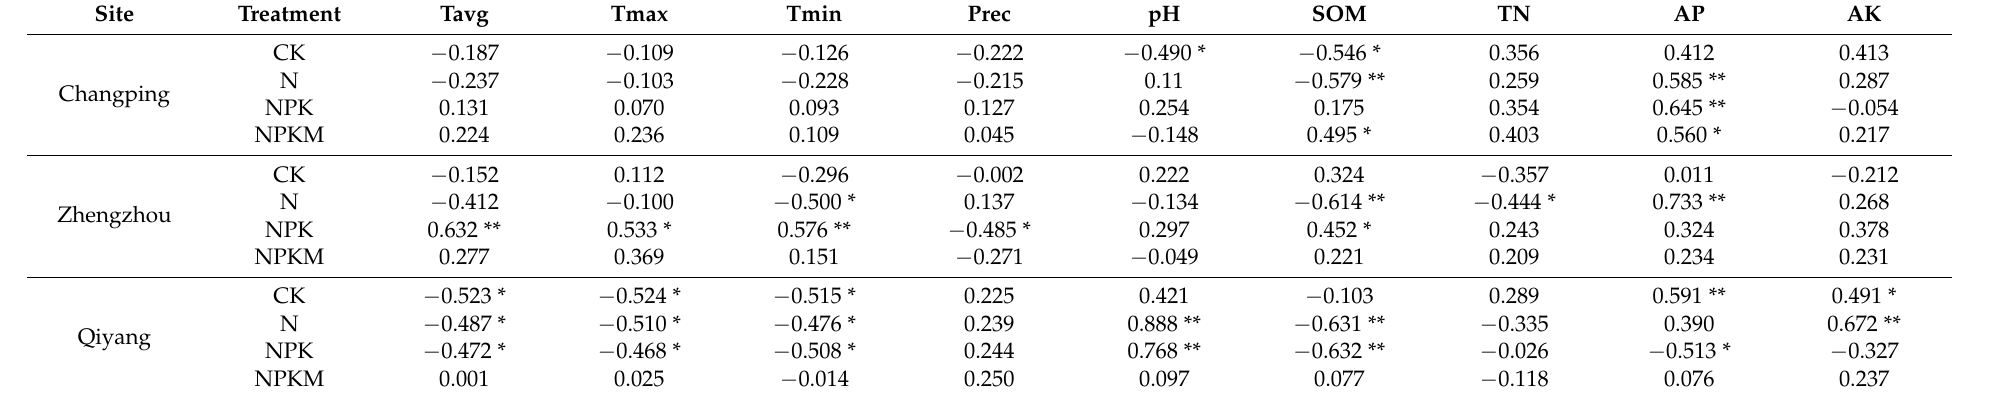
Table 3. The correlation coefficients between wheat yields and main climatic and soil fertility factors in the three experimental sites. Site